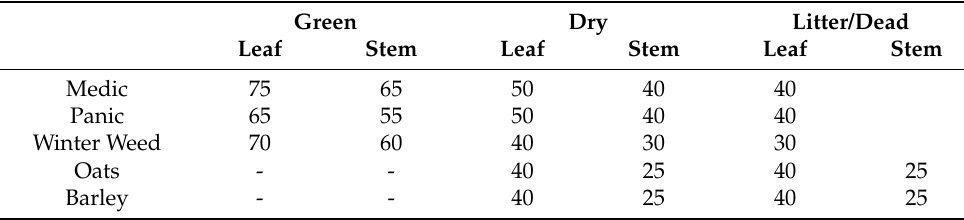
Table A1. Dry matter digestibility (DMD, %) of different interrow pasture species and different plant parts. Note the oats grain was 65% digestible (or 9.5 MJ/kg).